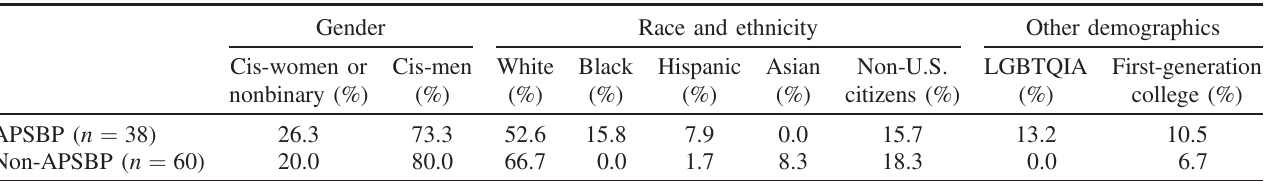
TABLE III. Students ’ demographic information. Note that the students that self-identified with more than one race were 5.2% from the two APSBP sites and 5.1% from the two non-APSBP